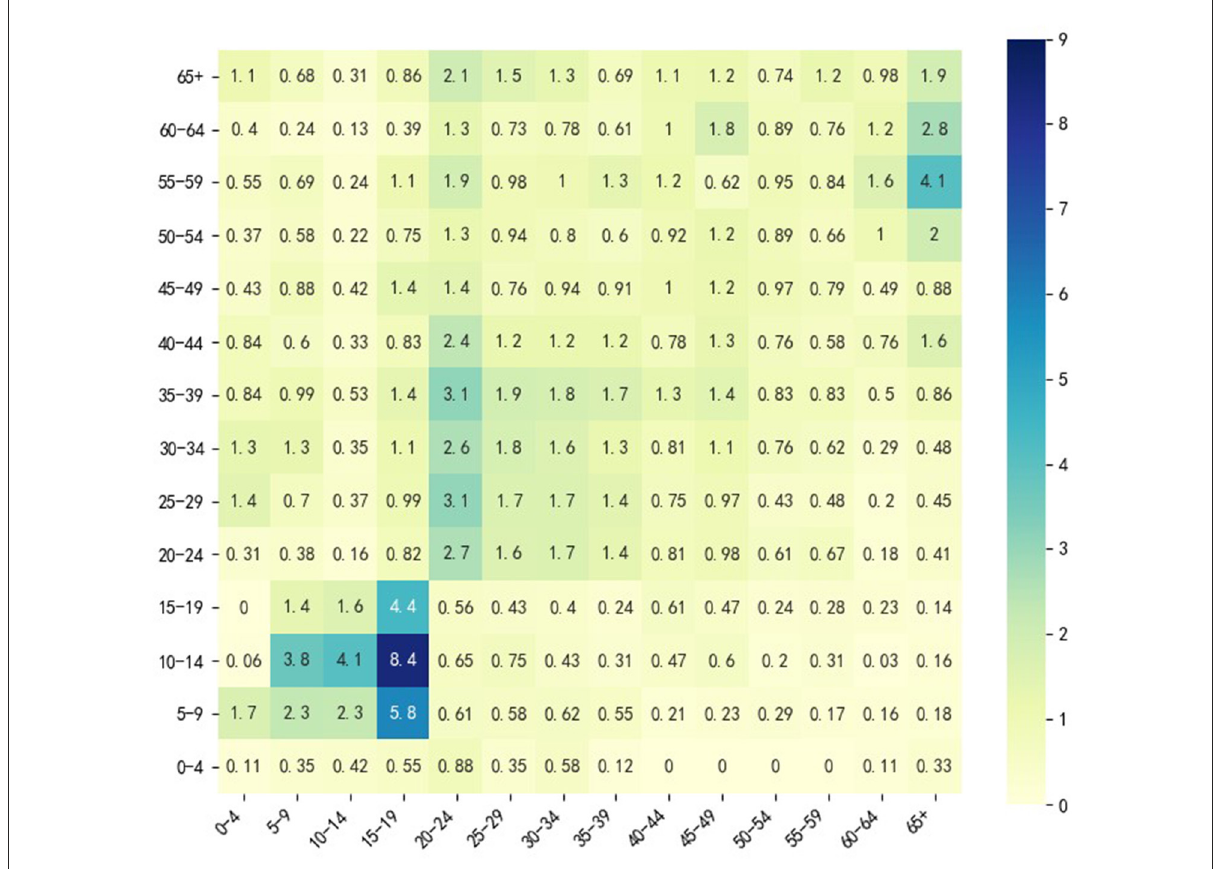
FIGURE3 Heatmap of M in Wuhan